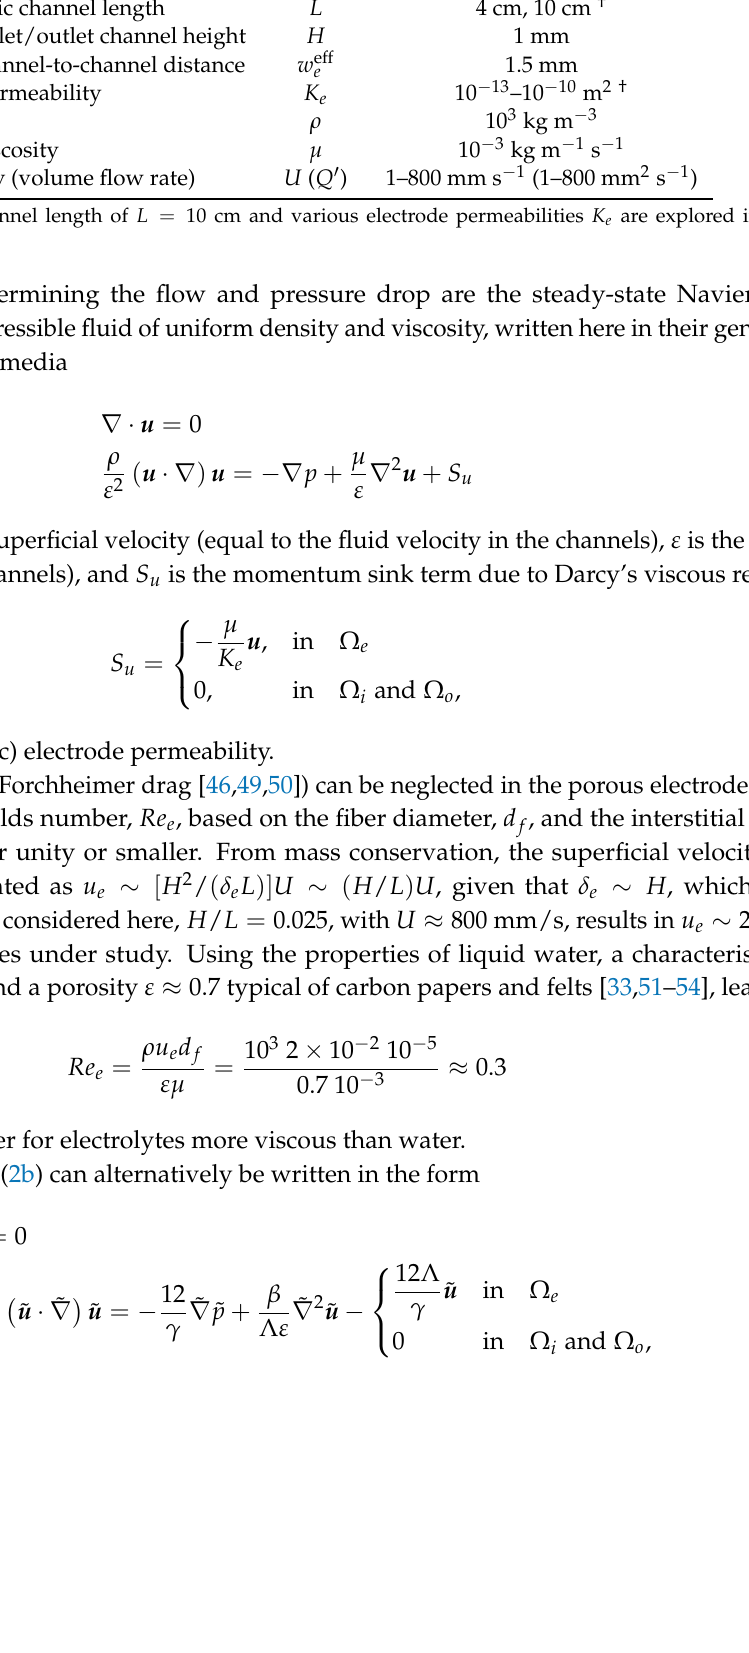
Table 1. Geometrical parameters, fluid properties and operating conditions used in the 2D CFD model.